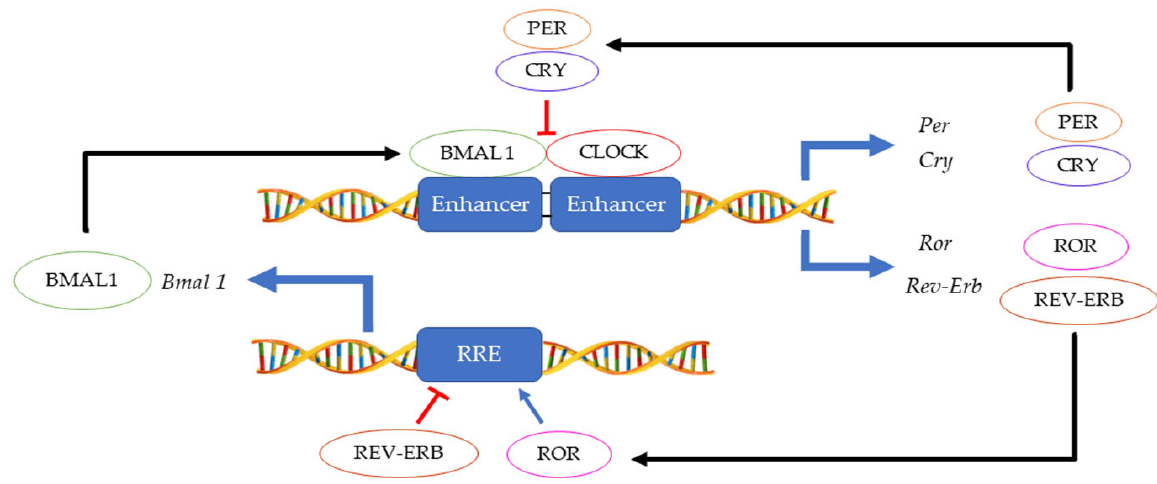
Figure 1. Main feedback loops regulating the circadian clock.